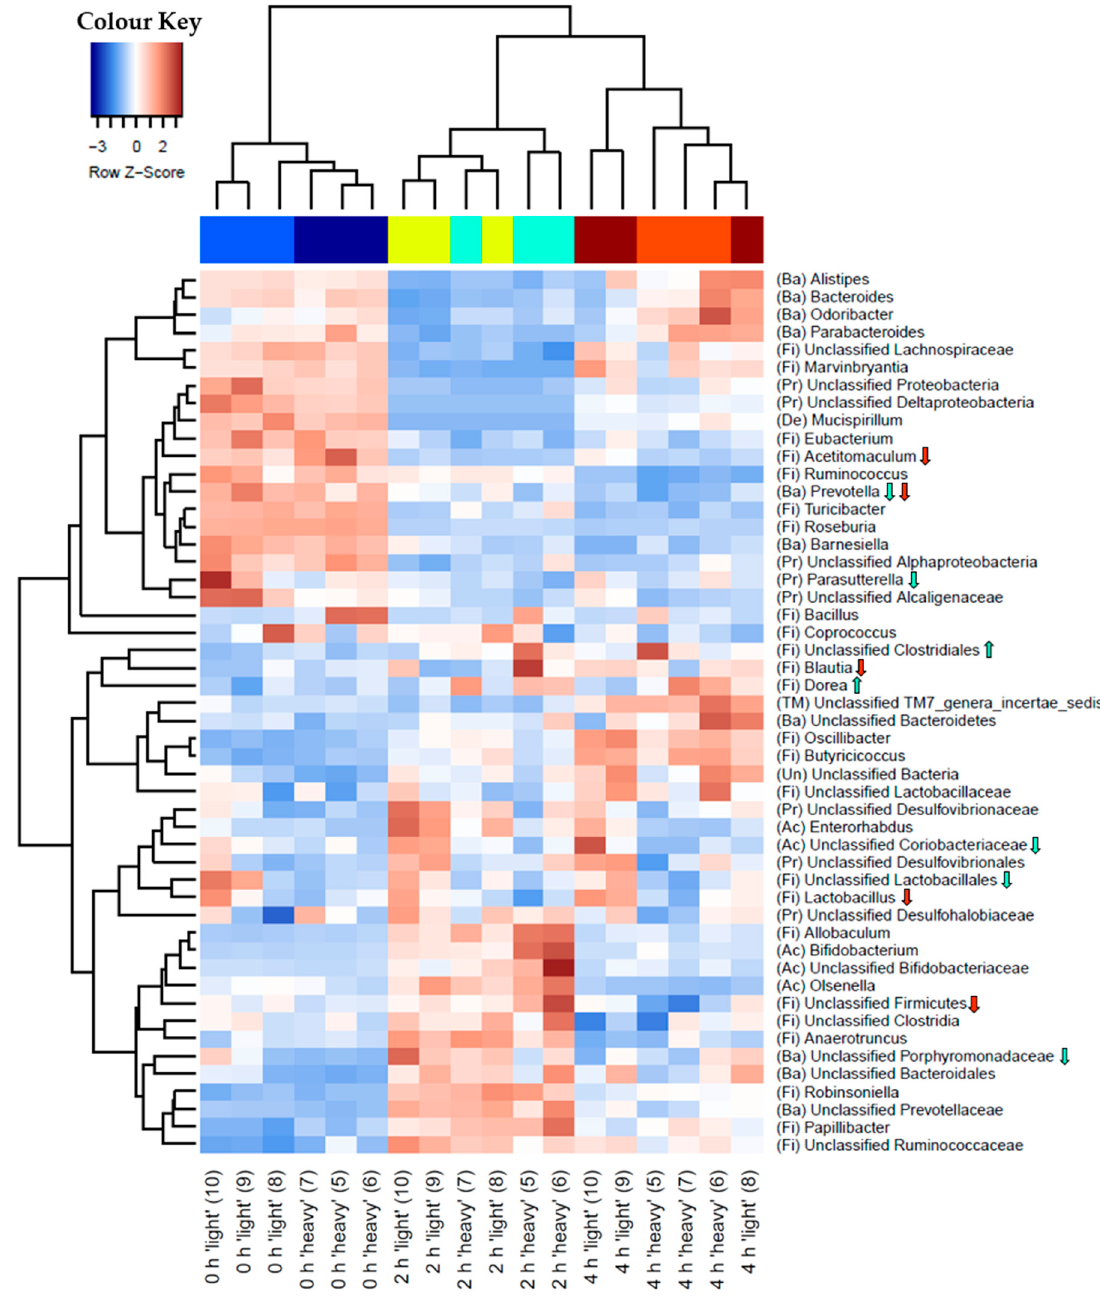
Figure 2. Heatmap of hierarchical clustering of bacterial microbiota composition profiles represented by 16S ribosomal RNA (rRNA) amplicons per sample of ‘heavy’ and ‘light’ gradient fractions at each sampling time. RNA from caecal contents was isolated before (0 h) or after provision of [U 13 C] starch (2 h and 4 h). The presented community profiles are results of three technical replicates for each fraction per sampling time. Bacteria shown represent the 50 taxa with the highest mean relative abundance across all fraction samples. Heatmap colour (blue to dark red) displays the row scaled relative abundance of each taxon across all samples. The number in parentheses indicates the corresponding fraction number. Letters in parentheses preceding taxonomic labels indicate the phylum (Ac = Actinobacteria , Ba = Bacteroidetes , De = Deferribacteres , Fi = Firmicutes , Pr = Proteobacteria , Ve = Verrucomicrobia , Un = Unclassified). Arrows indicate either increase or decrease at p ≤ 0.05 in ‘heavy’ fractions compared to the corresponding ‘light’ fractions as calculated by permutation ANOVA with 2000 permutations using density as factor at 2 h (green arrows) and 4 h (red arrows).